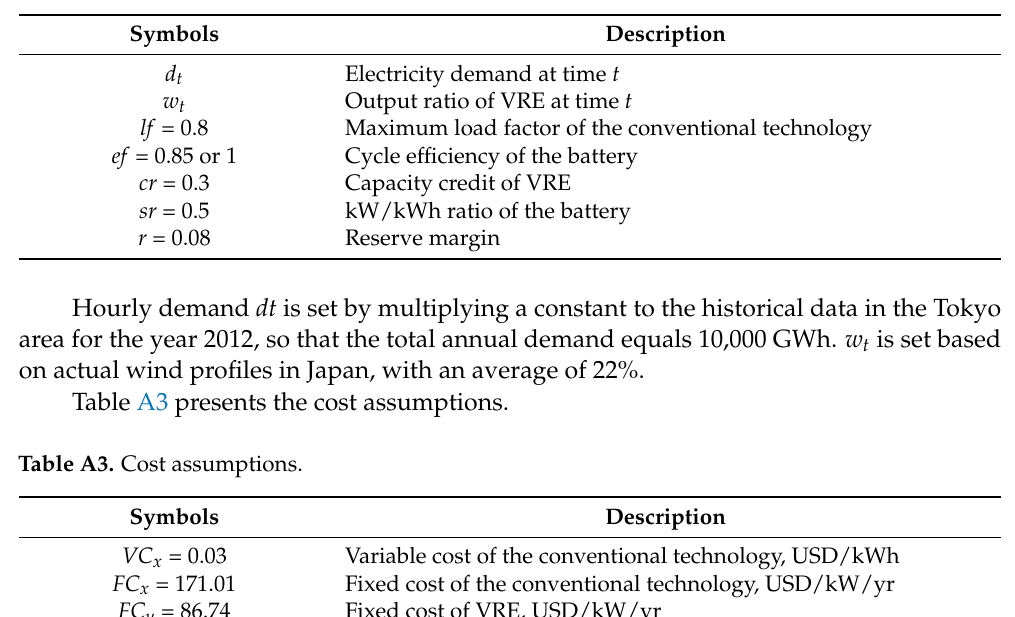
Table A2. Exogenous variables and